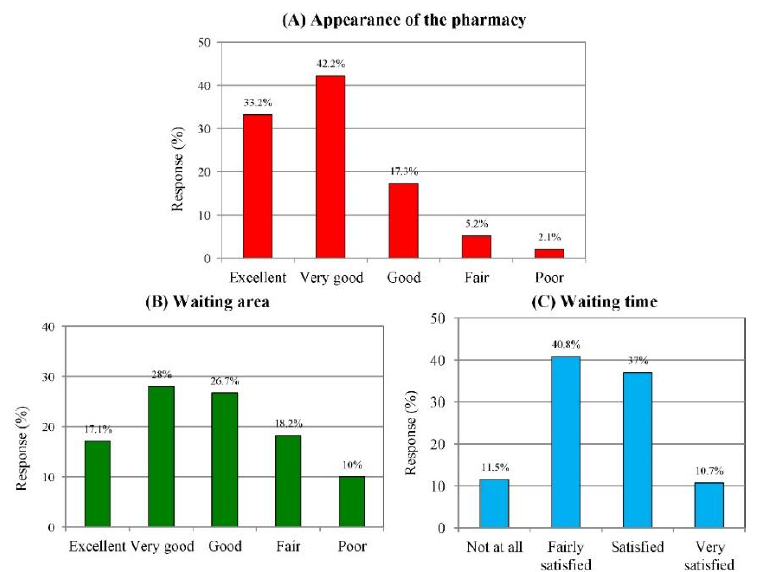
Figure 1. Customers ’ views on pharmacy appearance ( A ), waiting area ( B ) and busyness ( C